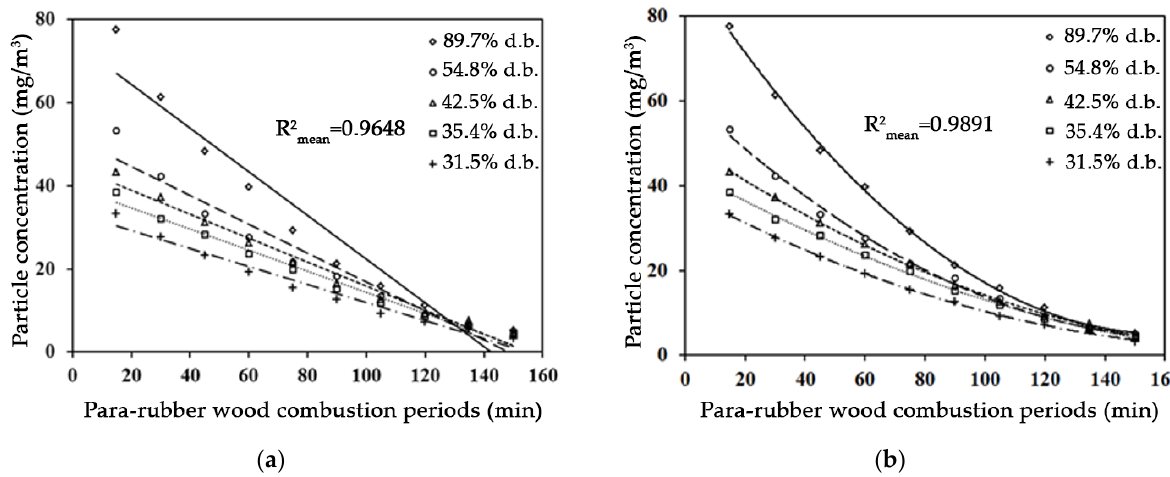
Figure 9. Comparison of predicted and experimental TPMC values: ( a ) First-degree model; ( b ) Second-degree model.